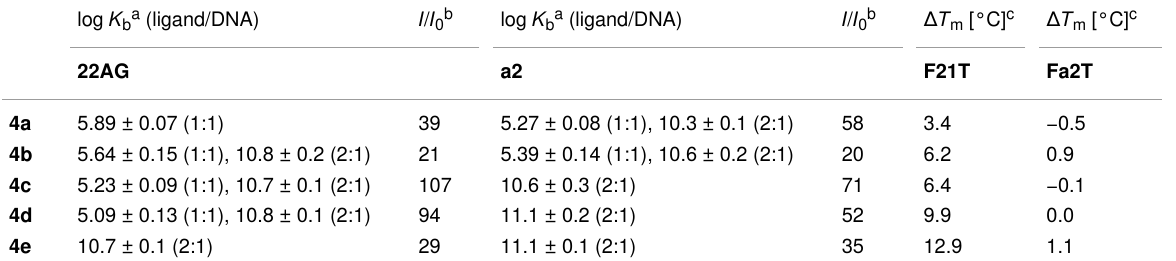
Table 1: The binding constants, K b , fluorescence light-up factors, I / I 0 , and shifts of the melting temperature, Δ T m , of compounds 4a – e with